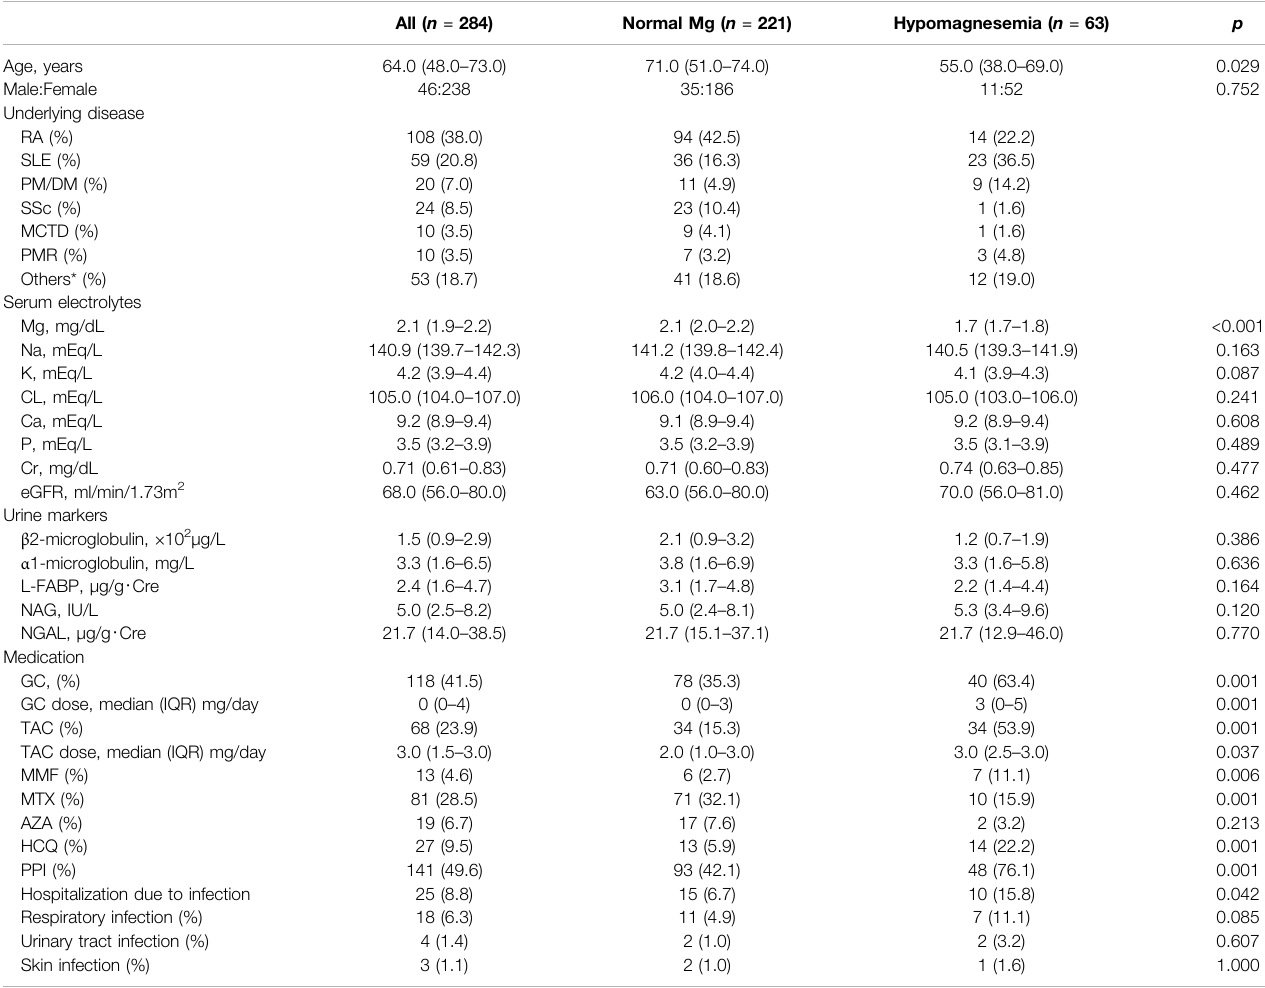
TABLE 1 | Patient